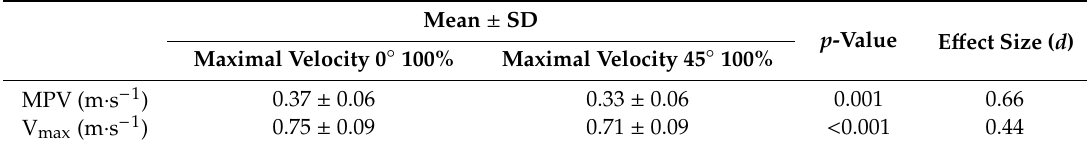
Table 1. Mean, SD, p -value and e ff ect size for the MPV and V max comparing the conditions executed at the maximal velocity.